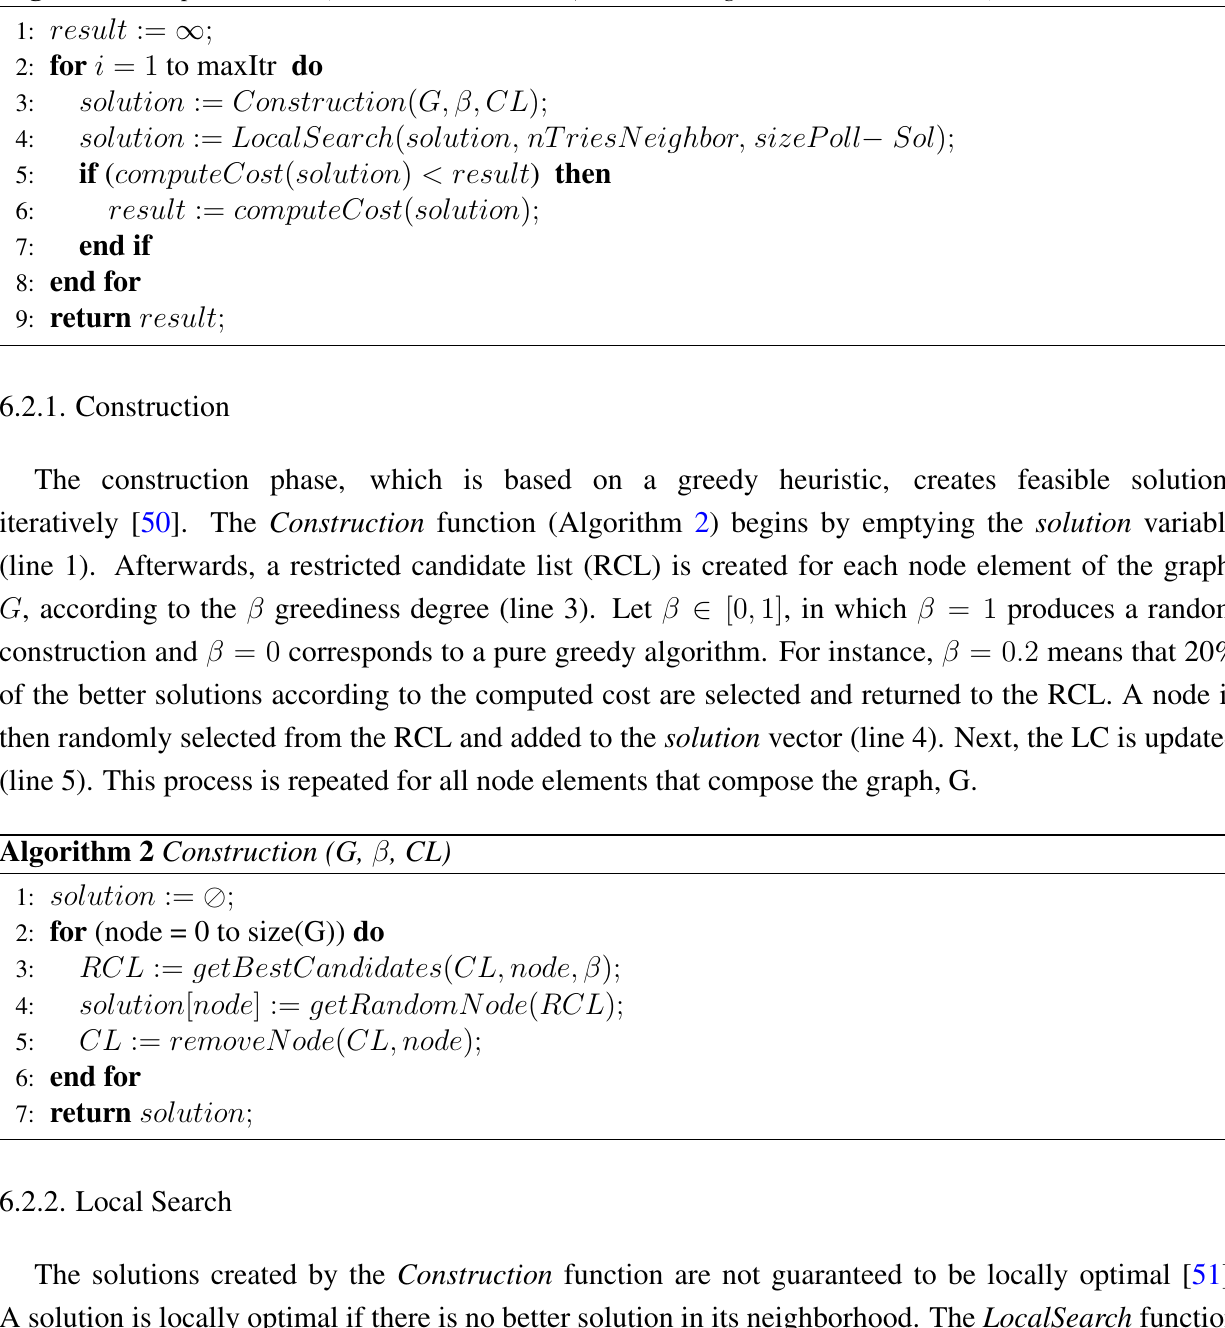
Algorithm 1 Optimization (G, maxItr, solution, β , nTriesNeighbor, sizePollSol, CL)